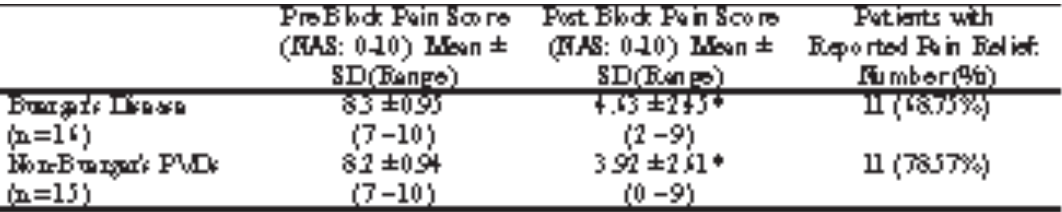
Table II : Pre and Post Block Pain Score and Pain Relief